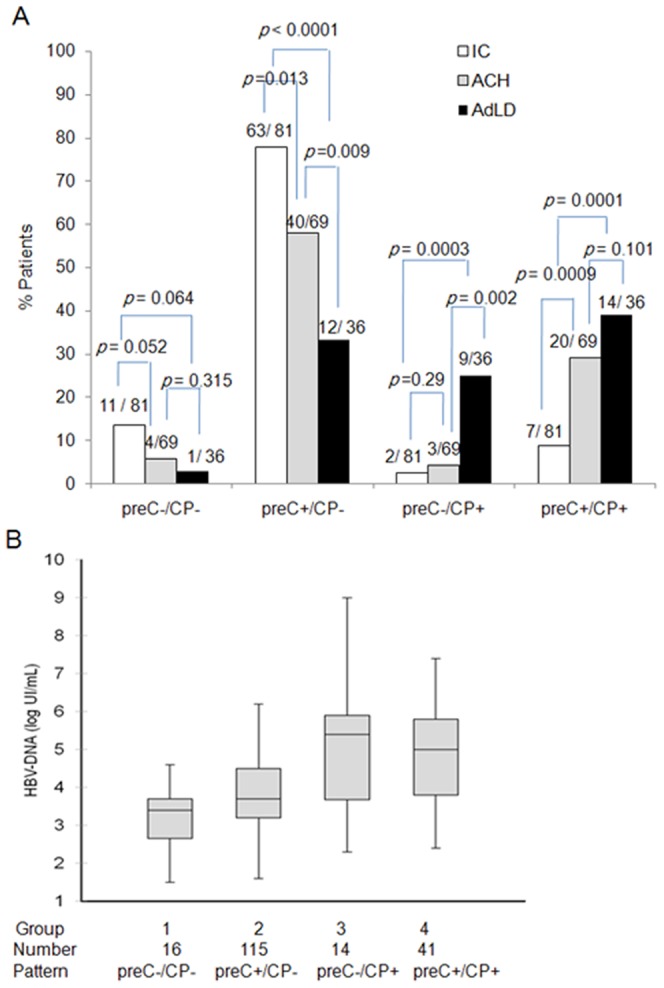
Association of the PreC/CP mutational patterns with clinical status (A) and HBV-DNA level (B).Four patterns (preC−/CP−, preC+/CP−, preC−/CP+, and preC+/CP+) were defined based on the presence (+) or absence (−) of pre-C mutation G1896A and CP A1762T/G1764A double mutation. For HBV-DNA levels, the data are presented as box plots, illustrated as the median (horizontal line) and the range from the 25th to the 75th percentiles. Group 1 vs 2, p = 0.09, Group 3 vs 1, p = 0.009; Group 3 vs 2, p = 0.02; Group 3 vs 4, p = 0.627; Group 4 vs 2, p = 0.02.